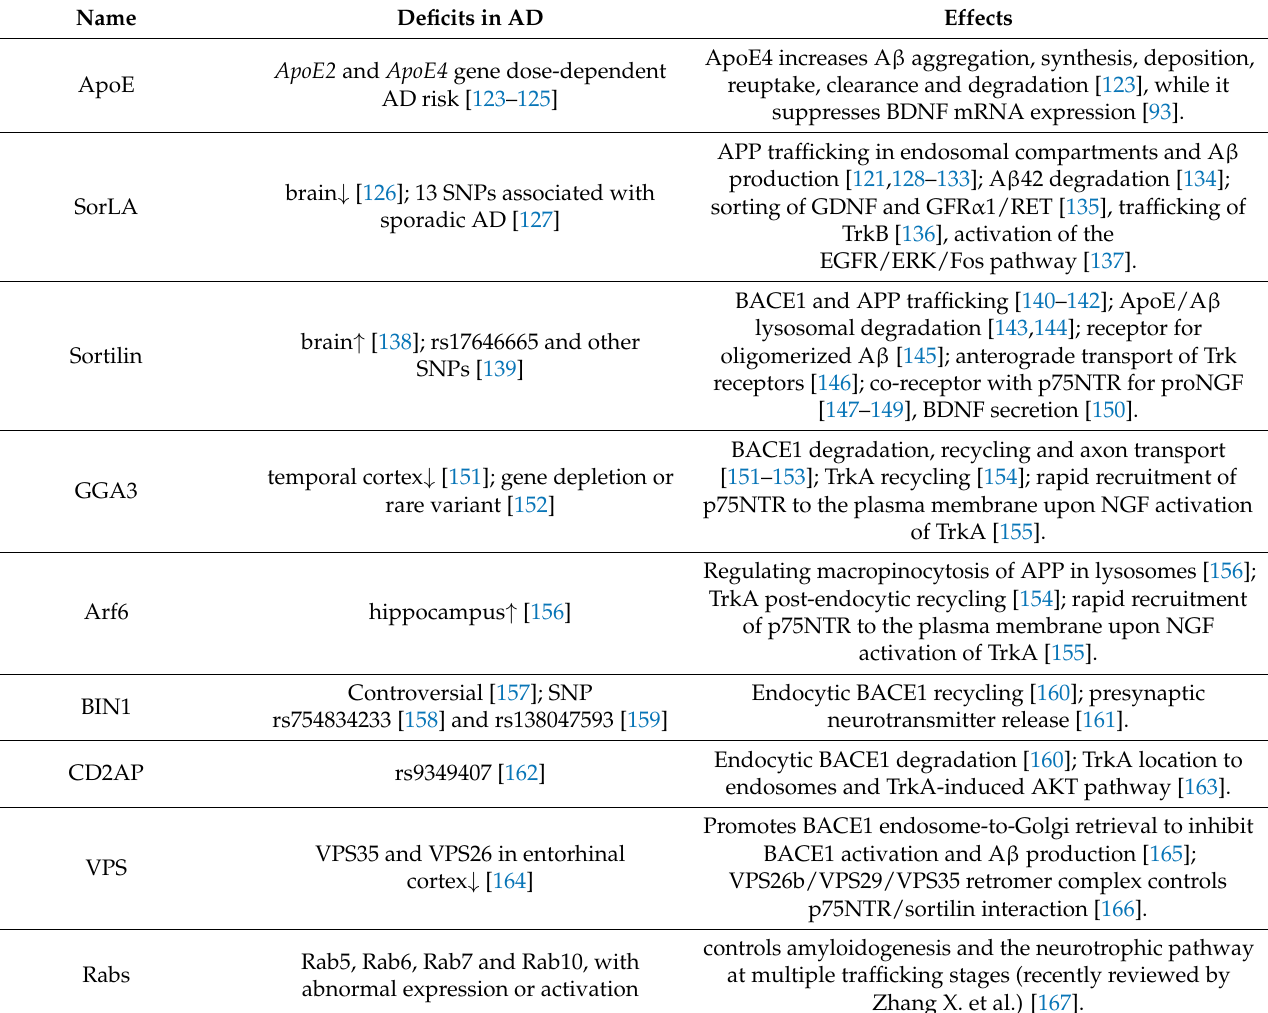
Table 2. Regulators involved in the amyloidogenic process and the neurotrophic pathways in